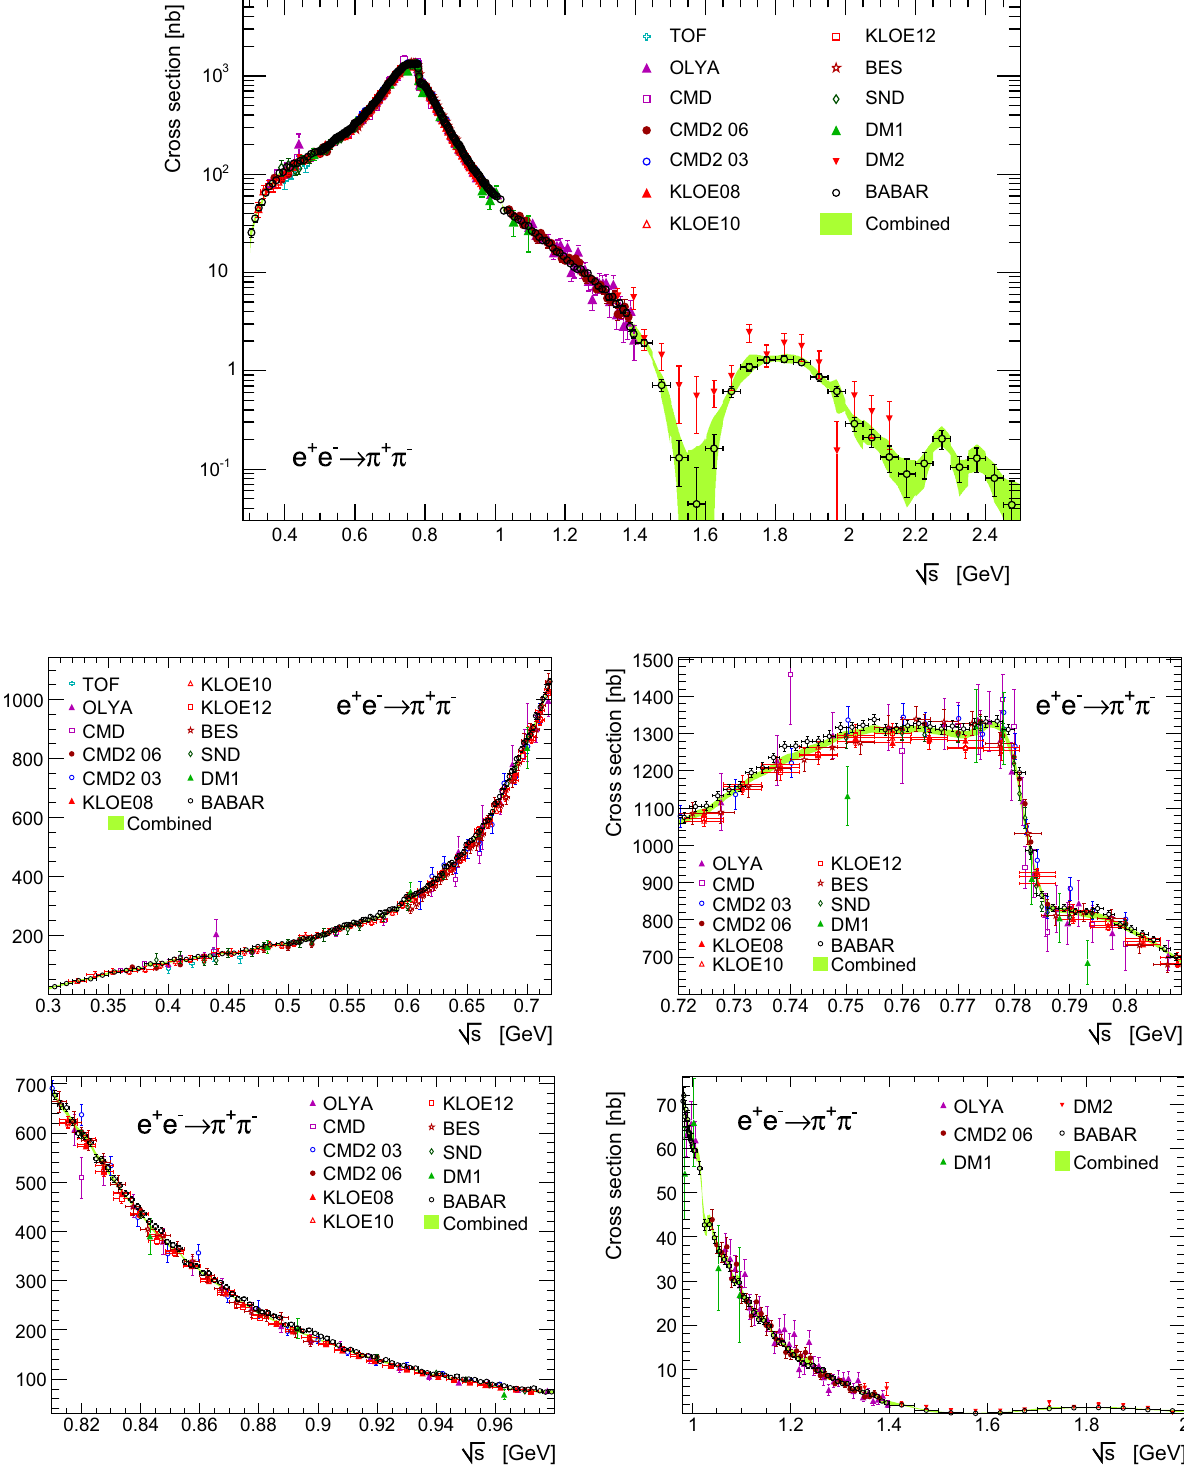
Fig. 1 Bare cross section of e + e − → π + π − versus centre-of-mass energy for different energy ranges. The error bars of the data points include statistical and systematic uncertainties added in quadrature. The green band shows the HVPTools combination within its 1 σ